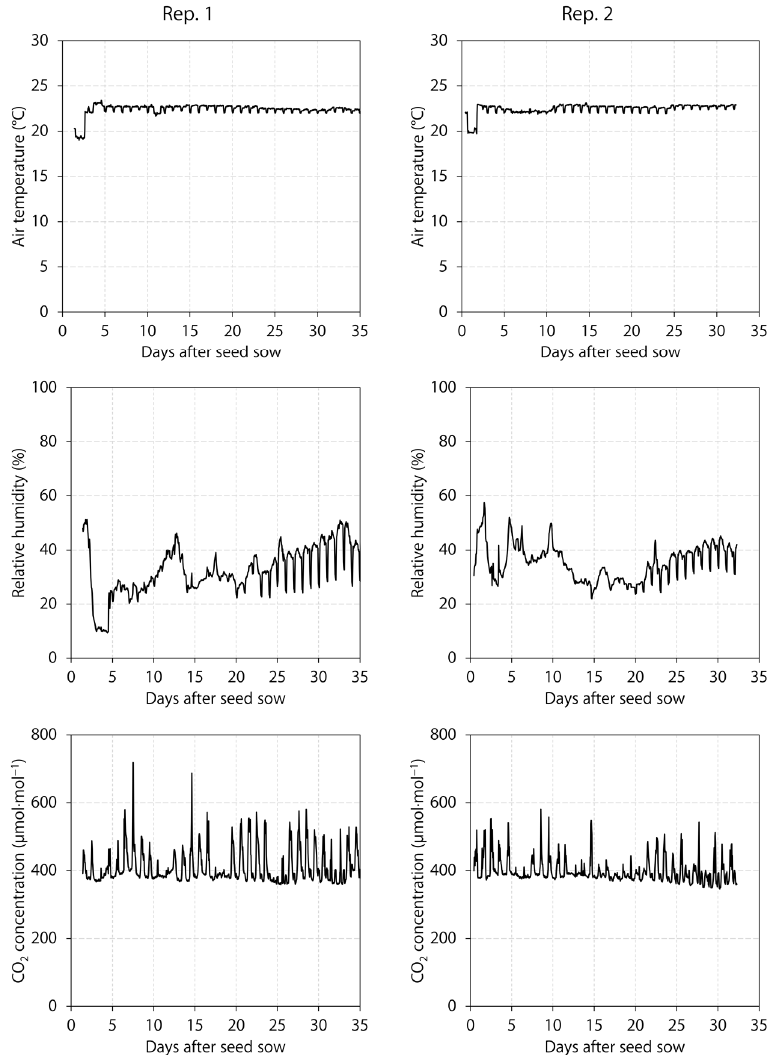
Figure 6. Air temperature, relative humidity, and CO 2 concentration throughout two experimental replications (Rep.) of the growth room housing six indoor lighting treatments delivered by warm- white, mint-white, blue, green, and/or red light-emitting diodes. The CO 2 peaks were caused by people inside the growth room.